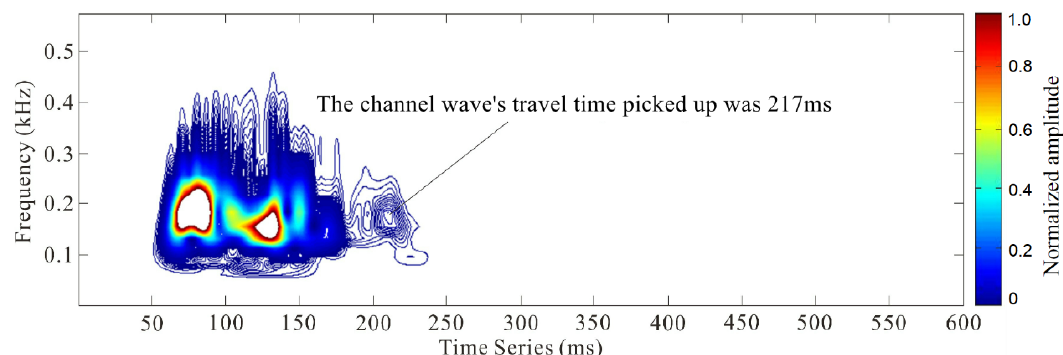
Figure 3. The time – frequency distribution of S5 – R7. Results of the time – frequency analysis applied to data from source station S5 recorded at receiver station R7.